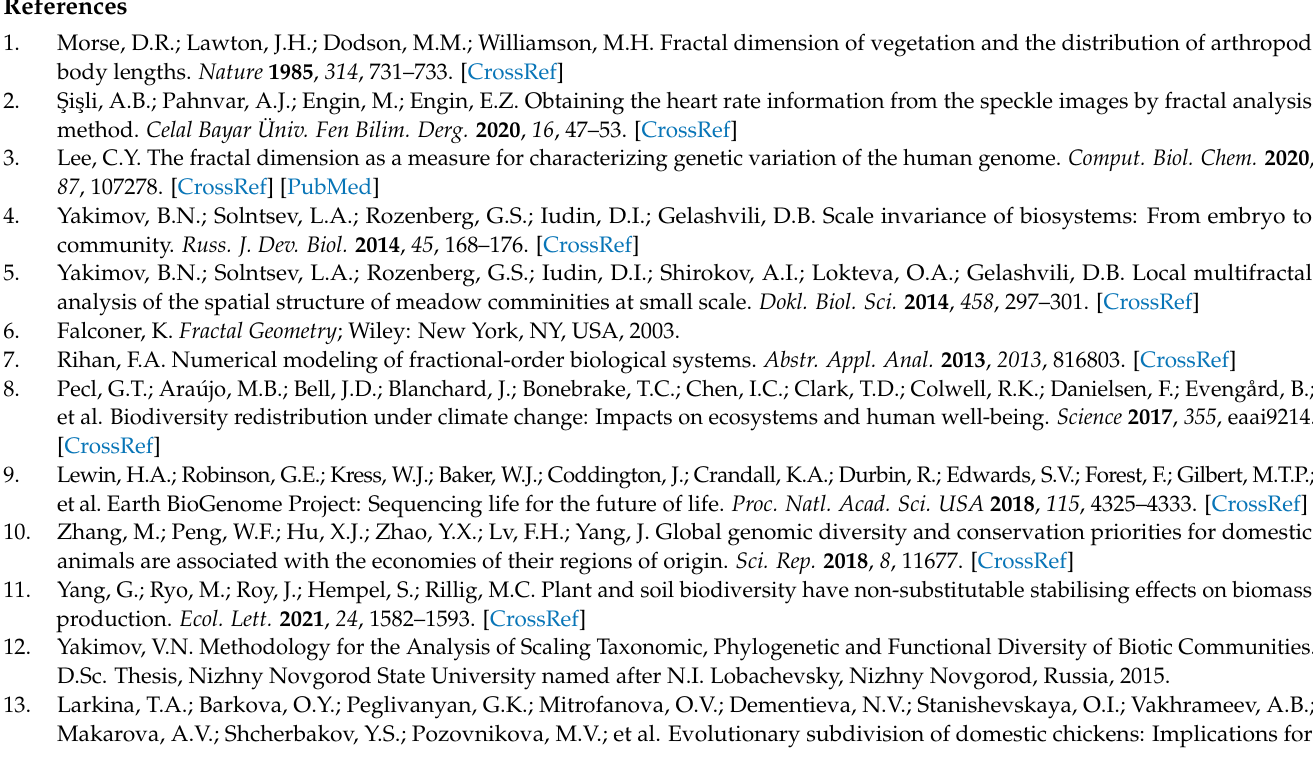
Table S13: Transformation of numerical indicators of fold change (FC) for gene expression in the breast muscles of WC chick embryos into Y- and X-coordinates of points representing genes in a fractal portrait; Table S14: Correlation of the bioconsolidation index with the phenotypic characteristics of embryos and chicks of various chicken